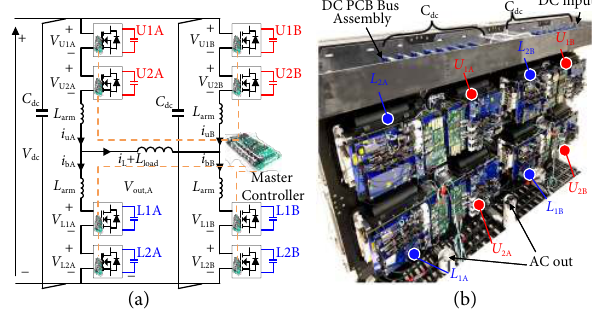
Fig. 14 (a) The modular converter pump-back test configuration schematic diagram. (b) Prototype of 10 kV SiC MOSFET-based two-cell-per-arm con- verter in pump-back test